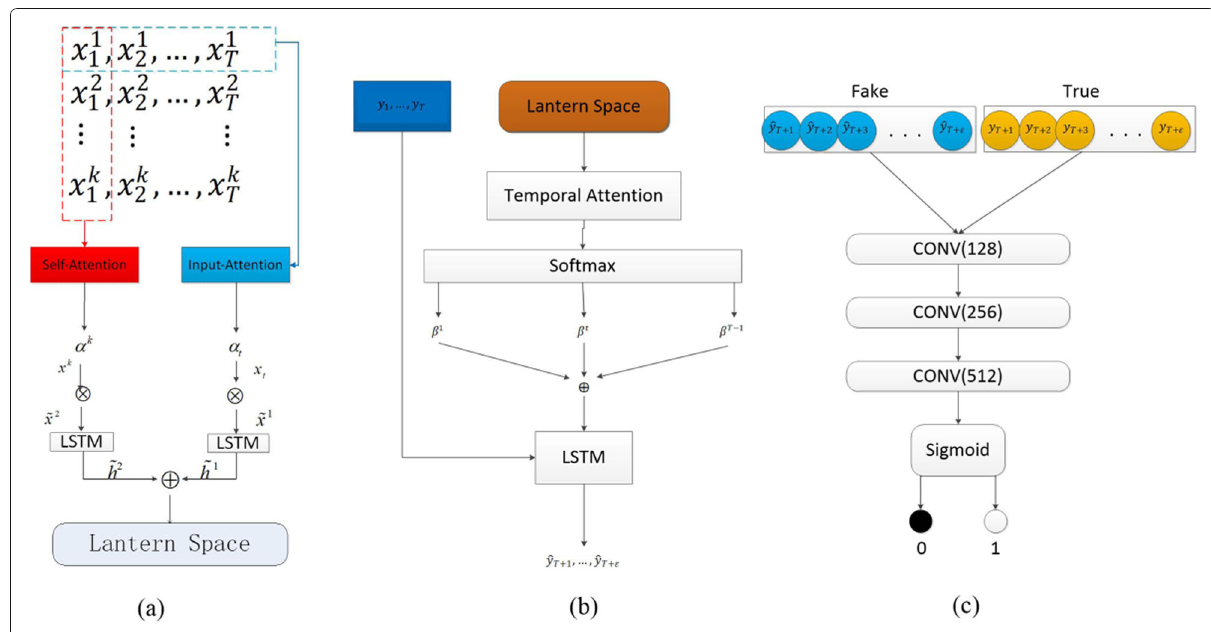
Fig. 2 The Architecture of The Encoder Network( a ), Generator Network( b ) and Discriminator Network( c )